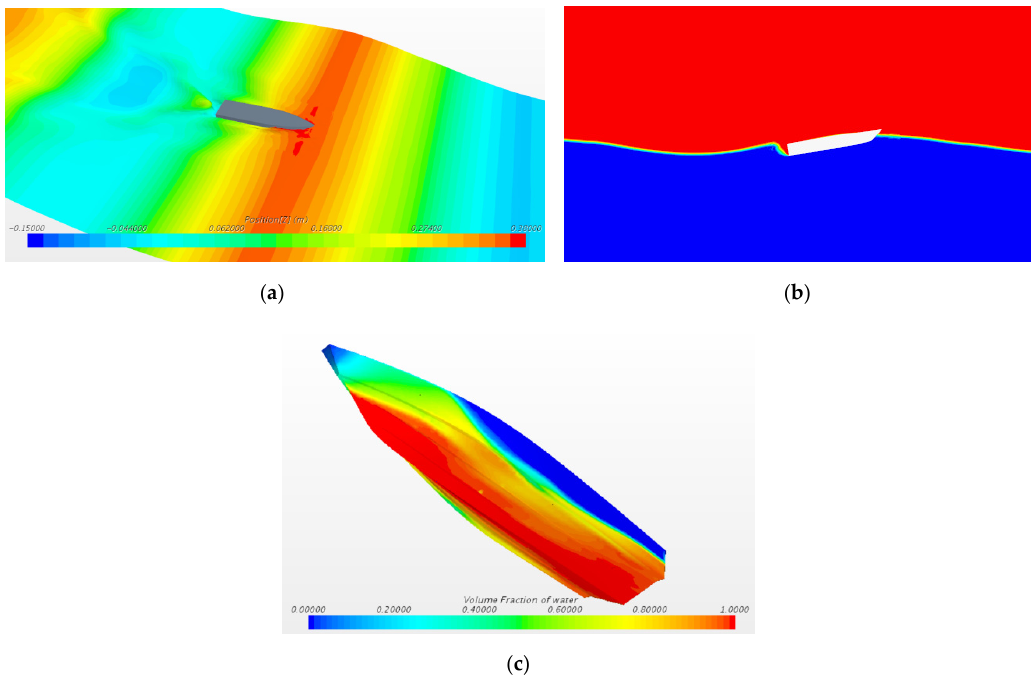
Figure 18. The simulation of the sailing of an improved vessel in the hull-borne status: ( a ) Free surface; ( b ) Gas–liquid phase diagram; ( c ) Free surface representation of the hull.